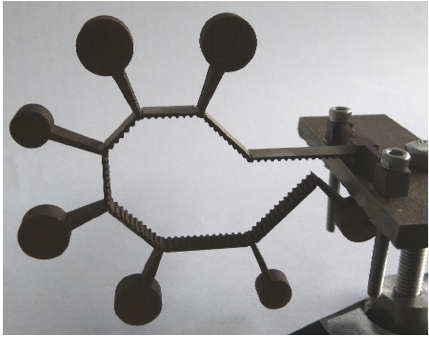
Figure 9: Prototype of piezoelectric energy harvester.